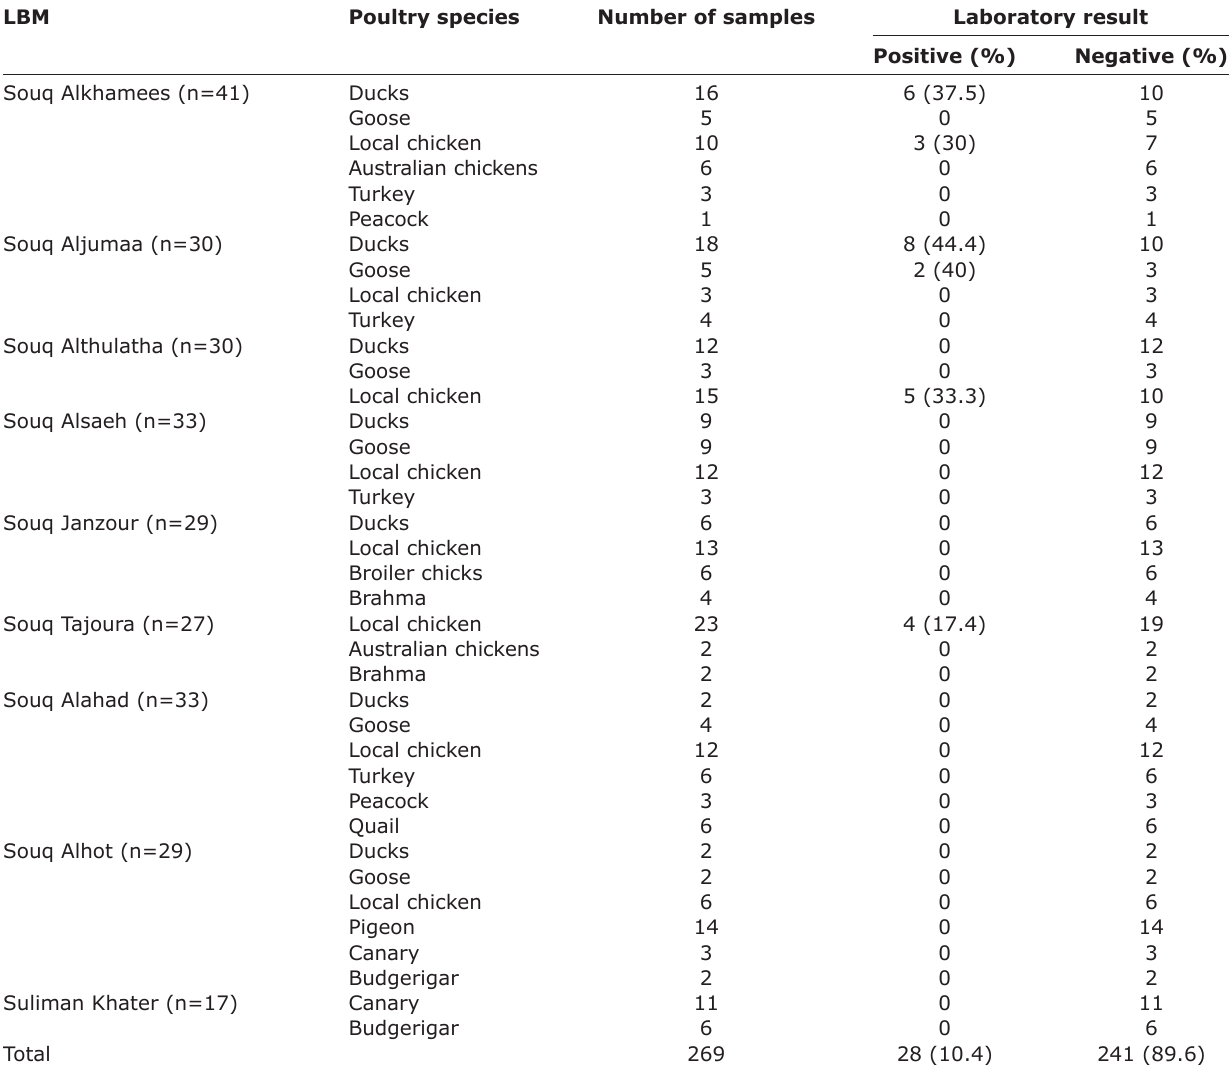
Table-1: The positive and negative results of the samples collected from LBMs located in Tripoli. LBM